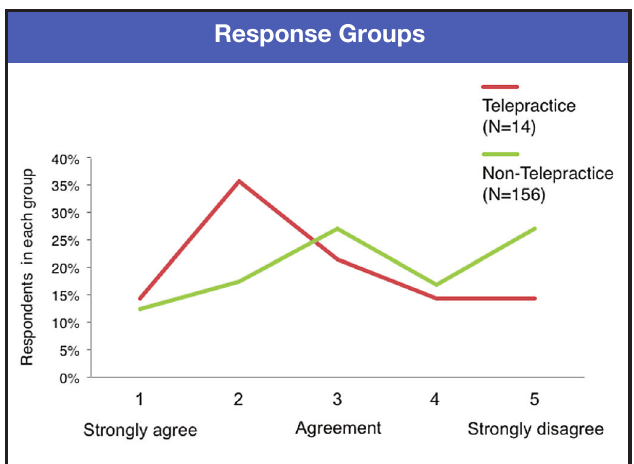
Figure 1. Comparison of Interest in Telepractice in School Settings.